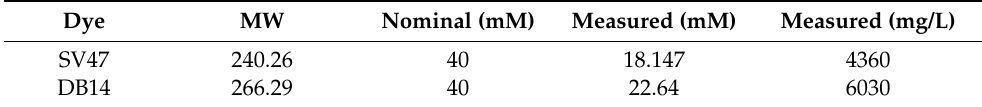
Table 3. Analytical chemistry results showing nominal versus measured concentrations.